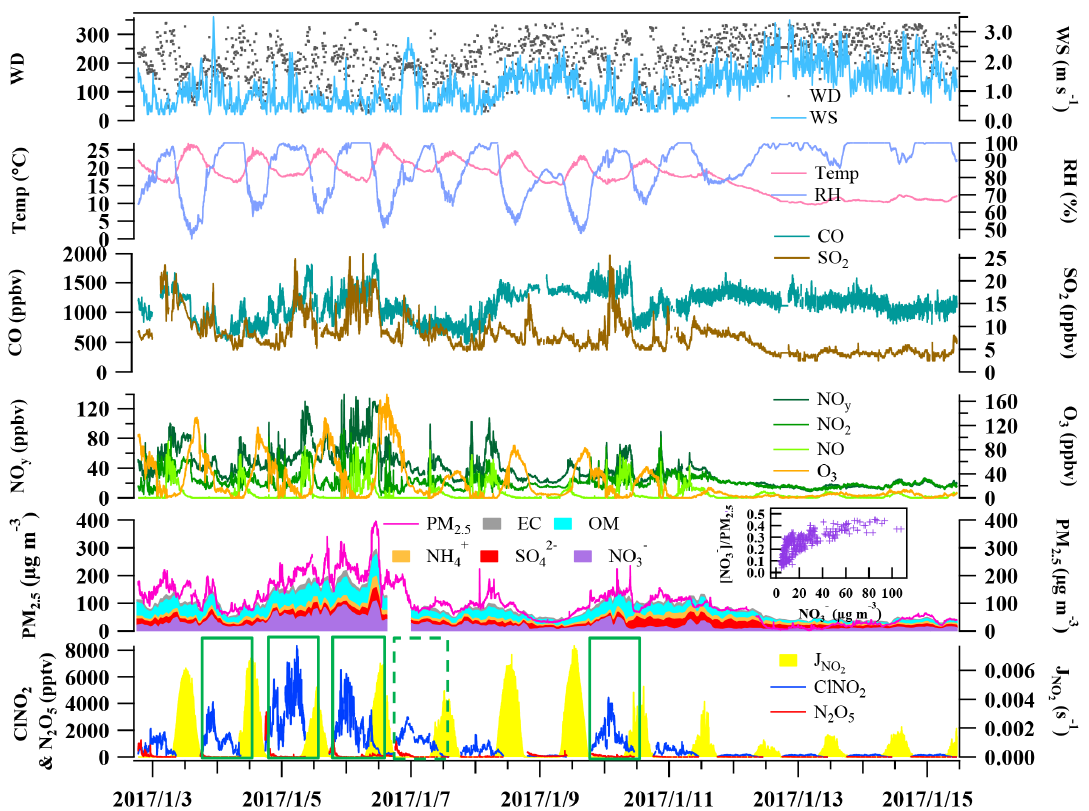
Figure 2. Time series of N 2 O 5 , ClNO 2 , components of PM 2 . 5 , and related trace gases and meteorological parameters from 18:40 on 2 January to 11:00 on 15 January 2017. The inset figure shows the variation of the ratio of nitrate to PM 2 . 5 with an increasing nitrate concentration. The green rectangles in the figure indicate the five days used for detailed analysis.